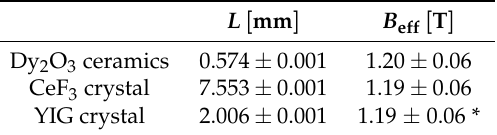
Table 2. The sample parameters used in the Faraday rotation dispersion calculations. The considered uncertainty of the applied B eff values is influenced by the magnetic field measurement error and by an undesired displacement of the sample from the maximum of the magnetic field. The estimation of the possible misplacement was purposely overestimated to be up to ± 2 mm from the maximum. * The value specified for the YIG crystal is listed only for the sake of completeness as the sample was characterized in the saturated